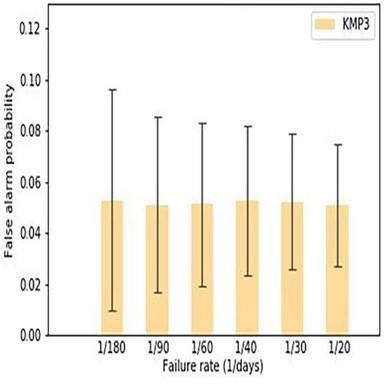
3. Given the false alarm probability of 0.05, different failure rate parameters bring different standard errors. While all the means of false alarm probabilities at KMP1, KMP2, and KMP3 are close to 0.05, the standard deviation of false alarm probabilities at KMP3 decreases as the failure rate parameter increases.